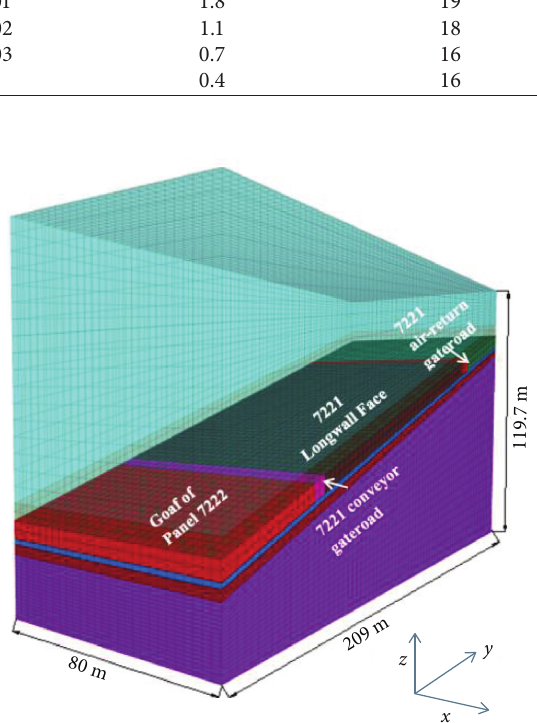
Figure 6: Numerical calculation